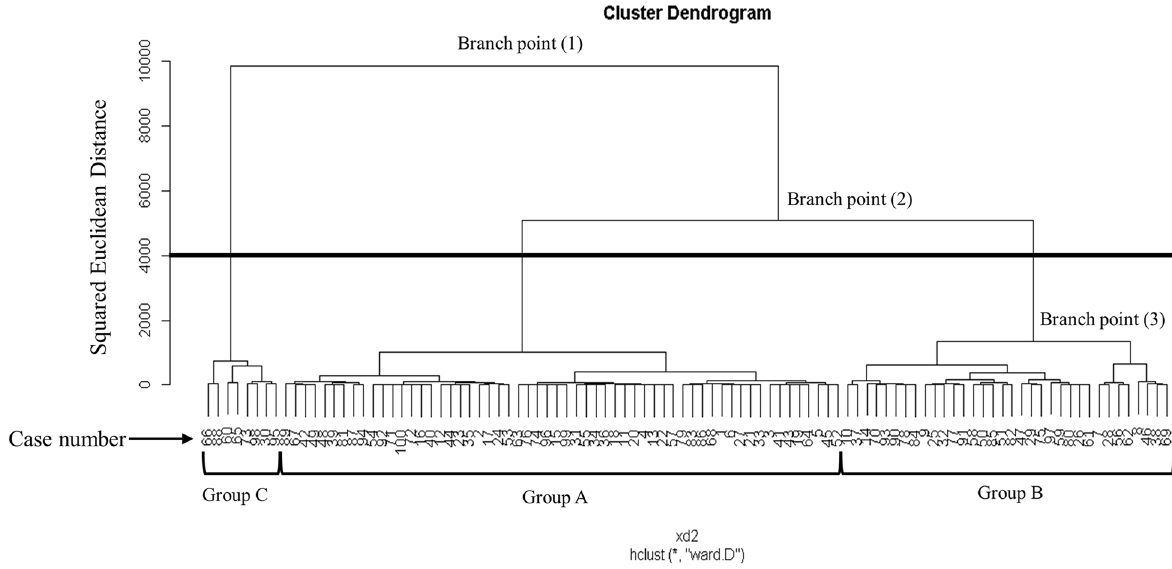
Fig. 3 Dendrogram from cluster analysis based on mandibular morphology. Branch point (1): squared Euclidean distance 10000. Branch point (2): squared Euclidean distance 5000. Branch point: squared Euclidean distance 1000. Solid horizontal line indicates the cutoff part